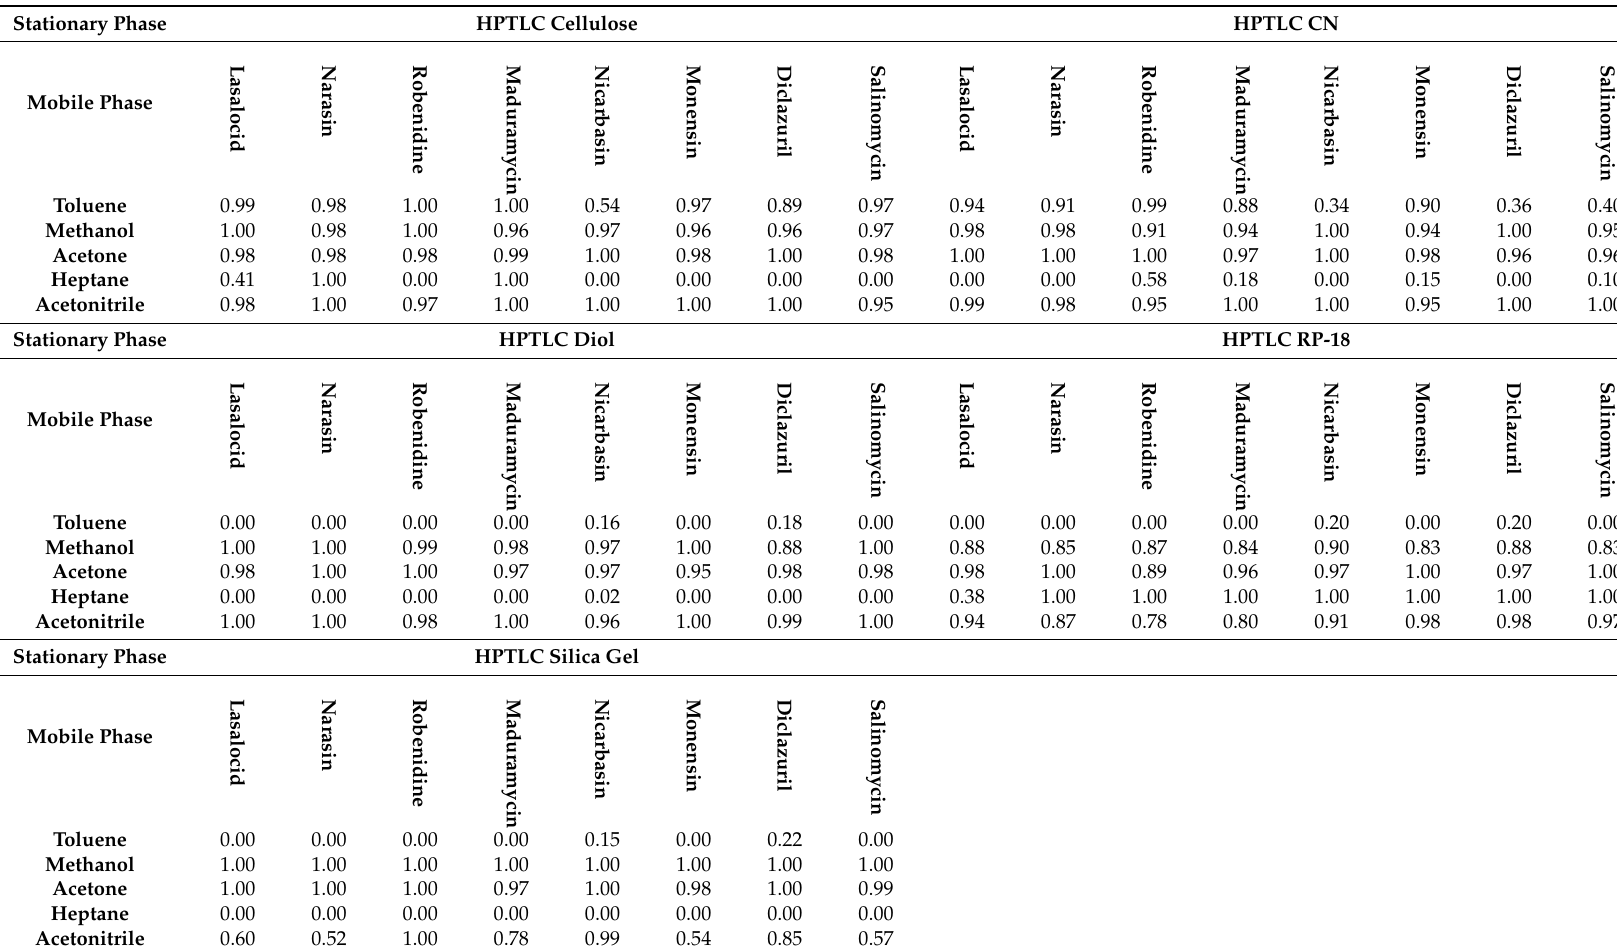
Table 1. Values of R f coe ffi cient of coccidiostats for tested chromatographic